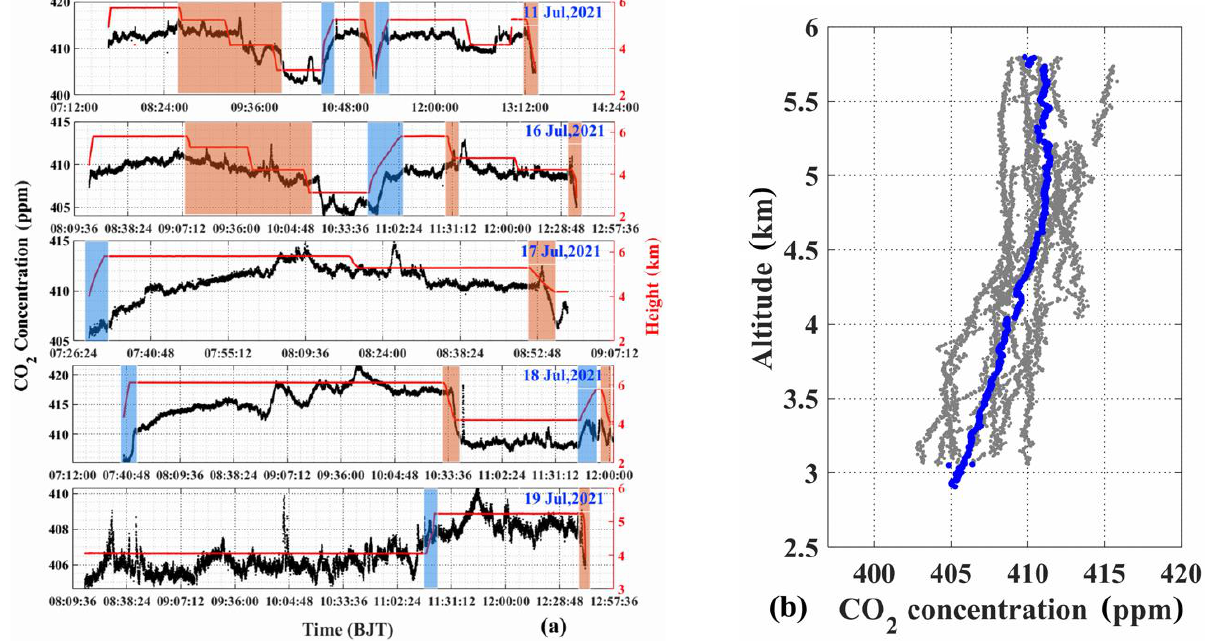
Figure 8. The CO 2 concentration distribution measured by airborne UGGA in July 2021 ( a ) and the CO 2 concentration vertical structure ( b ). In Figure 8a, the time period when the aircraft’s flight altitude is decreasing is marked by orange shading. The time when the aircraft’s flight height is increasing is marked with light blue shading. In Figure 8b, the gray scatters represent the results at different heights for all CO 2 concentrations marked with shading in Figure 8a. The blue scatter points represent the average of all grey scatter points at different heights.